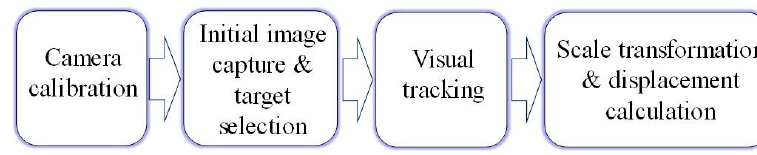
Figure 1. General procedure of the vision-based displacement measurement methods.